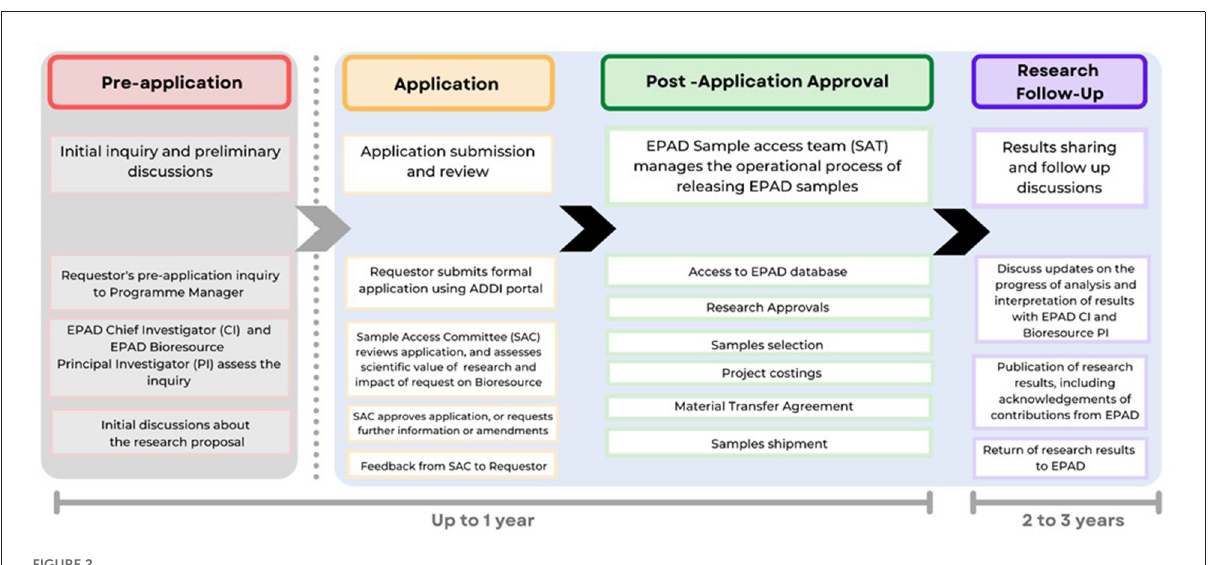
FIGURE2 Requestor’s journey to access EPAD samples and corresponding